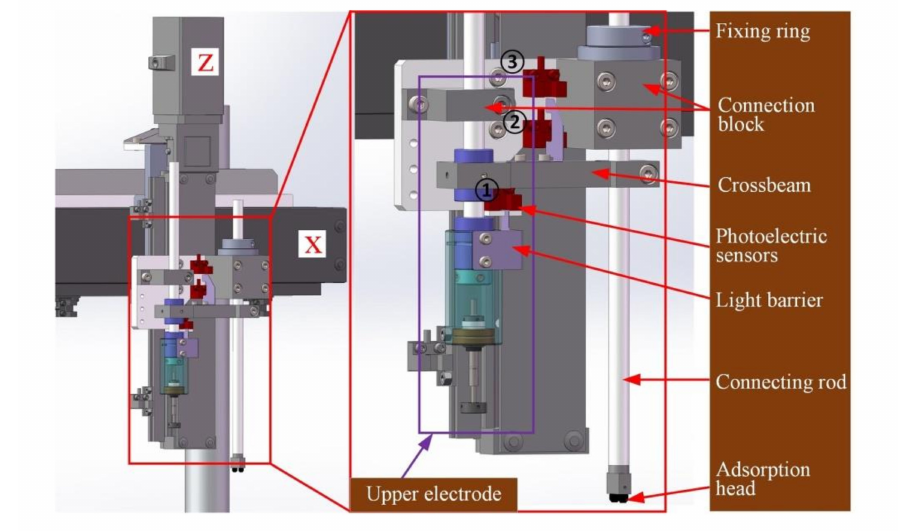
Figure 5. Structure of the operating